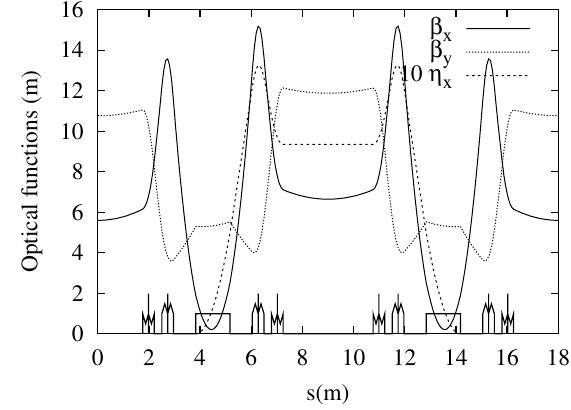
FIG. 12. One of the four Super-ACO double bend achromat